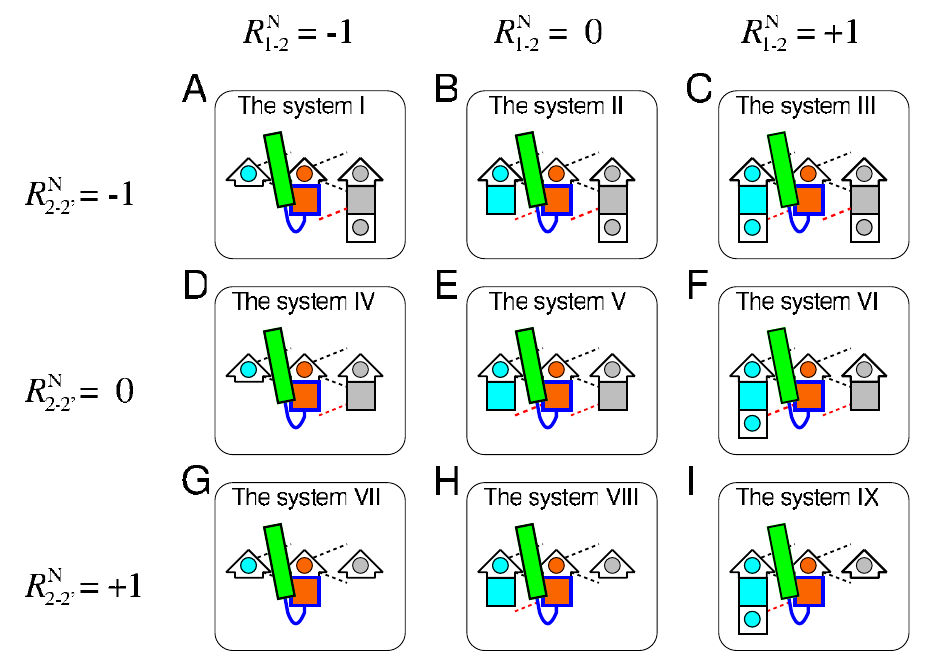
Fig 4. Schematic representations of nine target systems for all atom simulation. Figures (A)–(I) show schematic representations of the system I–IX, respectively. Each system consists of the αβ -unit and the three-stranded β -sheet structure with different register shifts. The arrows represent β -strands and the rectangles represent α helices. In the β - strands, residues located at the C-terminus are indicated by short arrows, and other residues are shown as squares. A square (or a short arrow) with a circle inside represents a single amino acid residue with a side chain that is on the proximal side, and a colored filled square represents a residue with a side chain on the opposite side. The register shifts ð R N ; R N Þ of the systems I to IX were ( − 1, − 1), (0, − 1), (1, − 1), ( − 1, 0), (0, 0), (1, 0), ( − 1, 1), (0, 1), and (1, 1), 1 (cid:0) 2 2 (cid:0) 2 0 respectively. The residues indicated by blue are residues of which ϕ and ψ angles were exhaustively sampled. The black dotted lines indicate hydrogen bonds that were fixed in the exhaustive sampling, while the red dotted lines indicate hydrogen bonds that can be broken.